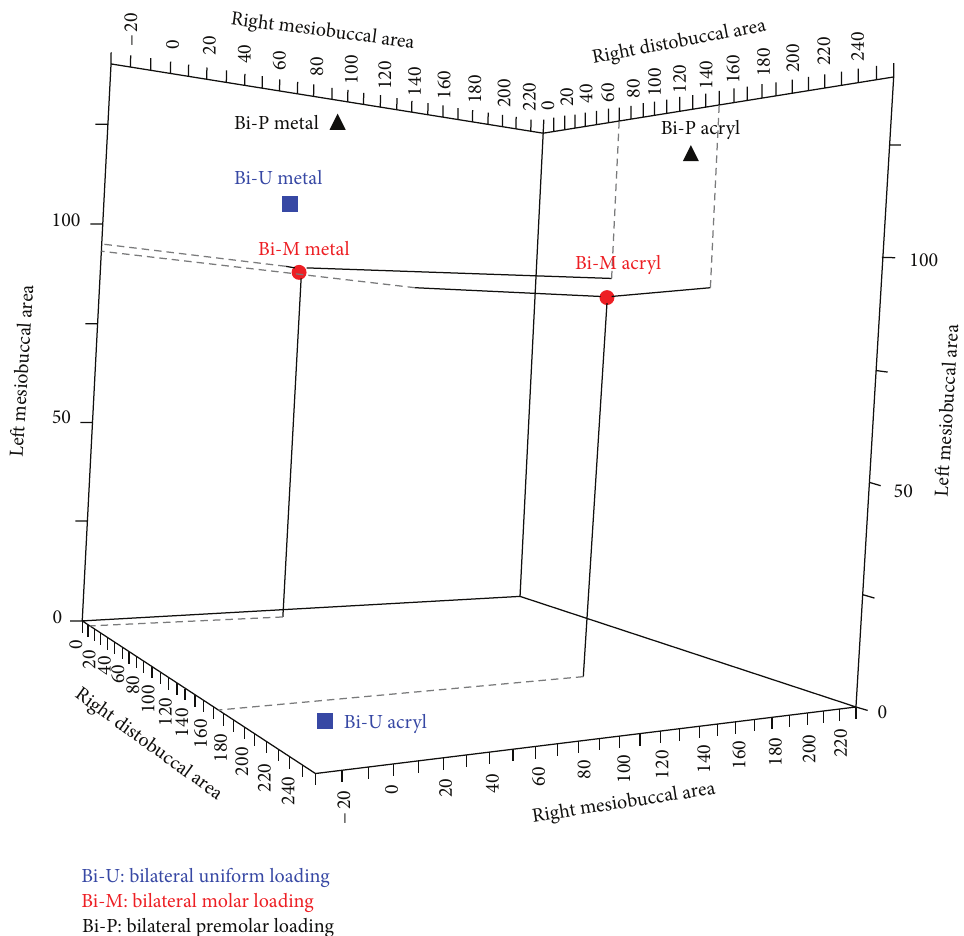
Figure 6: Comparison of microstrain values in both metal framework and acrylic base (bilateral loading conditions).